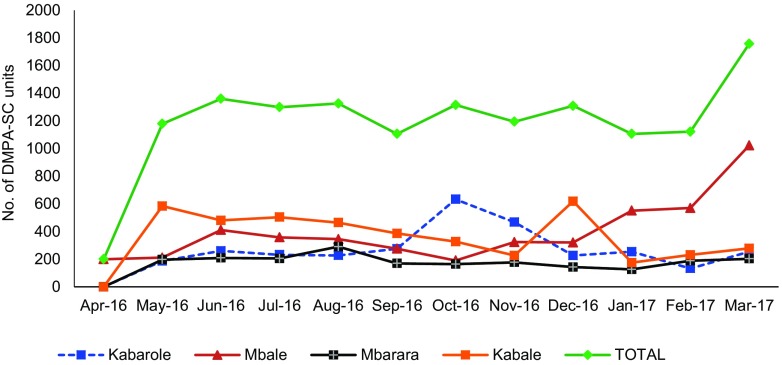
Monthly Trends in the Number of DMPA-SC Units Provided by District, Uganda, April 2016–March 2017Abbreviation: DMPA-SC, subcutaneous depot medroxyprogesterone acetate.